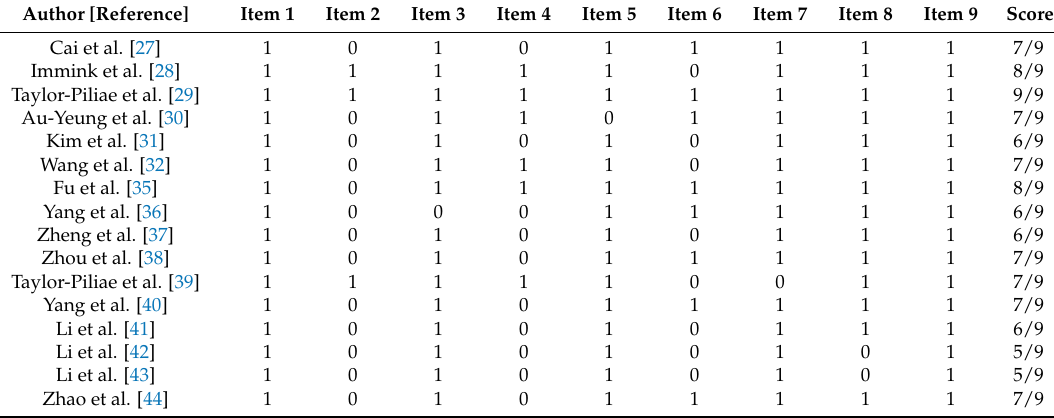
Methodological quality for randomized controlled trials and